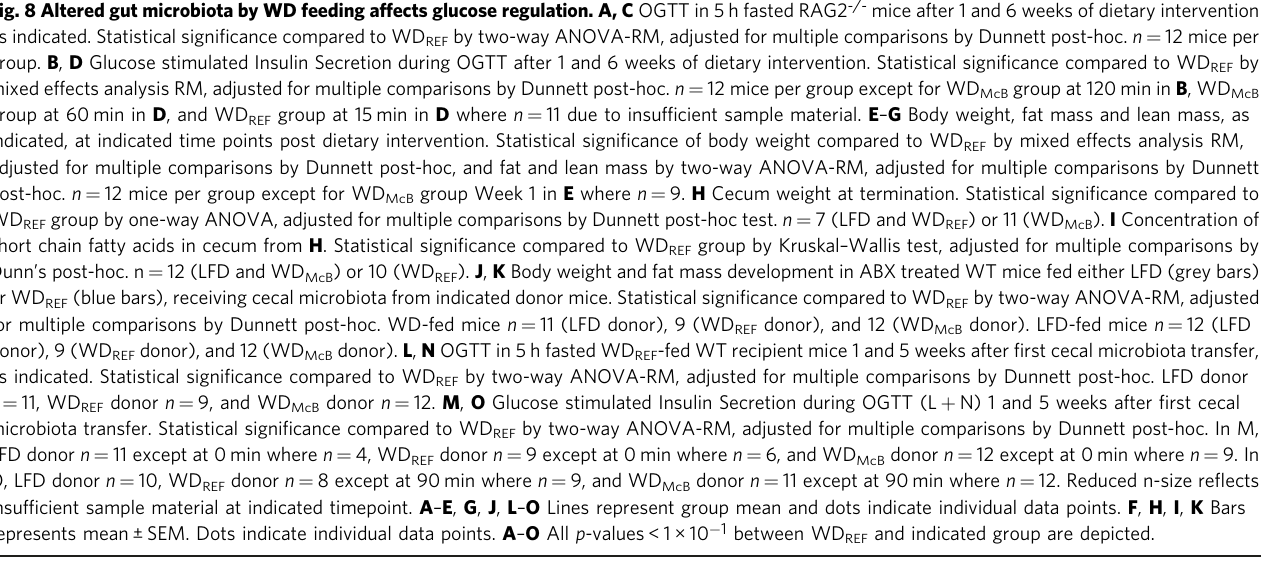
Fig. 8 Altered gut microbiota by WD feeding affects glucose regulation. A, C OGTT in 5 h fasted RAG2 -/- mice after 1 and 6 weeks of dietary intervention as indicated. Statistical signi fi cance compared to WD REF by two-way ANOVA-RM, adjusted for multiple comparisons by Dunnett post-hoc. n = 12 mice per group. B , D Glucose stimulated Insulin Secretion during OGTT after 1 and 6 weeks of dietary intervention. Statistical signi fi cance compared to WD REF by mixed effects analysis RM, adjusted for multiple comparisons by Dunnett post-hoc. n = 12 mice per group except for WD McB group at 120 min in B , WD McB group at 60 min in D , and WD REF group at 15 min in D where n = 11 due to insuf fi cient sample material. E – G Body weight, fat mass and lean mass, as indicated, at indicated time points post dietary intervention. Statistical signi fi cance of body weight compared to WD REF by mixed effects analysis RM, adjusted for multiple comparisons by Dunnett post-hoc, and fat and lean mass by two-way ANOVA-RM, adjusted for multiple comparisons by Dunnett post-hoc. n = 12 mice per group except for WD McB group Week 1 in E where n = 9. H Cecum weight at termination. Statistical signi fi cance compared